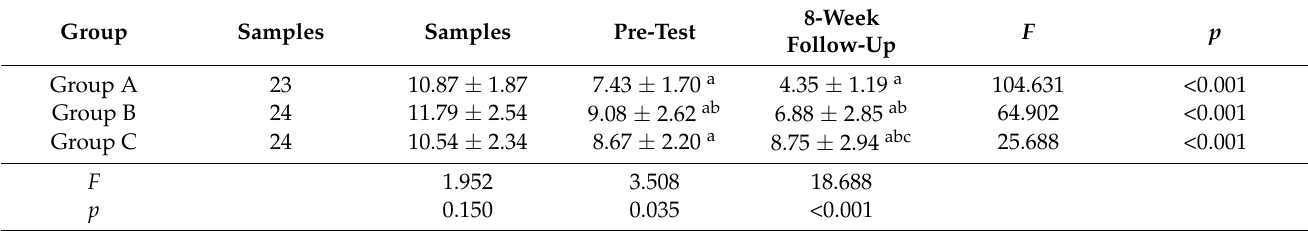
Table 5. PSQI scores in A, B, C ground at T 0 , T 1 , T 2 in terms of mean ± standard error (SE).